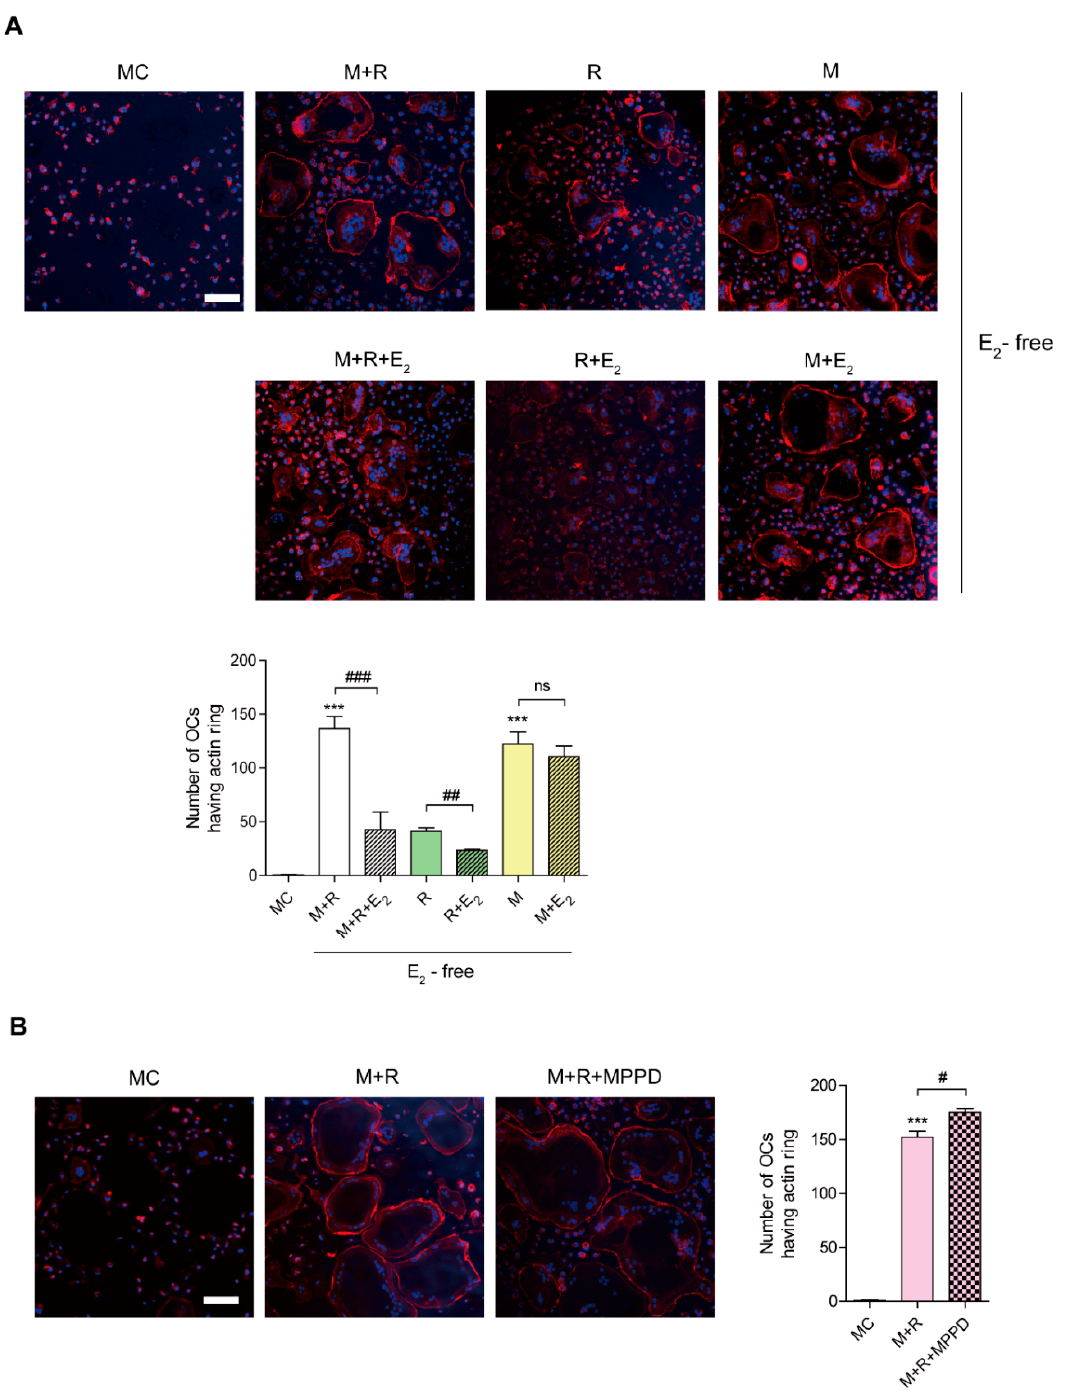
Figure 3. E 2 inhibits RANKL-stimulated actin ring formation. BMMs were cultured with M-CSF (30 ng/mL) and RANKL (40 ng/mL) for 96 h. ( A ) Cells were incubated with α -MEM/10% FBS (media control, MC) or with E 2 (5 nM) in the presence of M-CSF (M, 30 ng/mL) and/or RANKL (R, 40 ng/mL) as indicated. ( B ) Cells were incubated with α -MEM/10% FBS (media control, MC) or with MPPD (2 µ M) in the presence of M-CSF and RANKL. After a 4 h incubation, the cells were stained with rhodamine–phalloidin and Hoechst to visualize actin ring and nuclei, respectively. ( A , B ) show representative images. Scale bar, 100 µ m. The number of OCs having actin rings was plotted for the indicated conditions. *** p < 0.001 compared with MC. # p < 0.05; ## p < 0.01; ### p < 0.001 compared with each corresponding control. Similar results were obtained in three independent experiments.